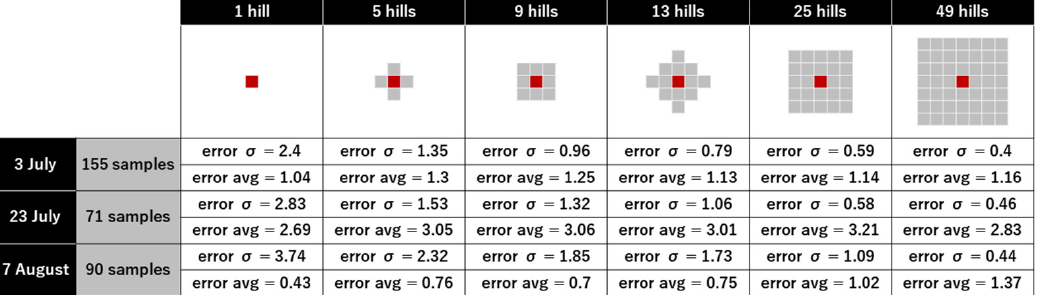
Figure 7. Accuracy of tiller-number estimation of multiple hills’ average (When there are various estimates for the same hill, the average value was used. Only observable hills in the range were considered. Data with observed values in more than one-third of the range were deemed to be valid. Observed average of grayed-out hills around red-painted hills.).